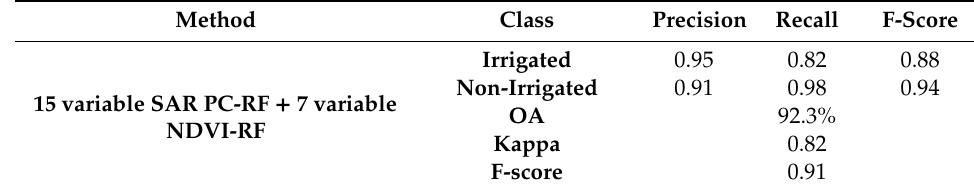
Table 6. The values of the overall accuracy, Kappa, F-score, precision, and recall obtained from the RF classifier using 15 important SAR PC variables and the seven important NDVI PC